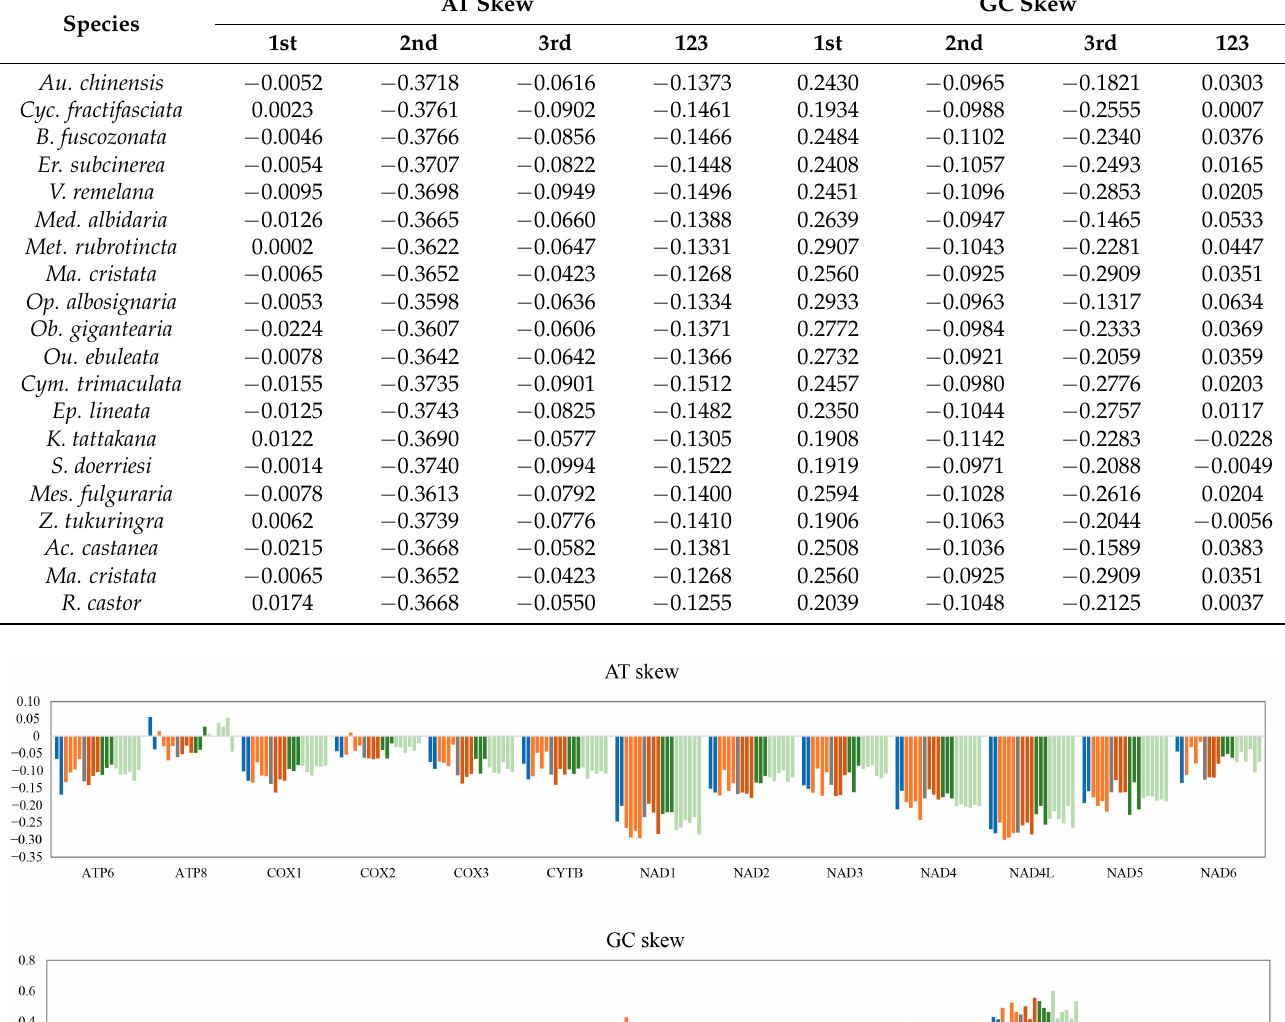
Table 2. AT and GC skew at different position of codon for 13 PCG genes in 19 moth mitogenomes.